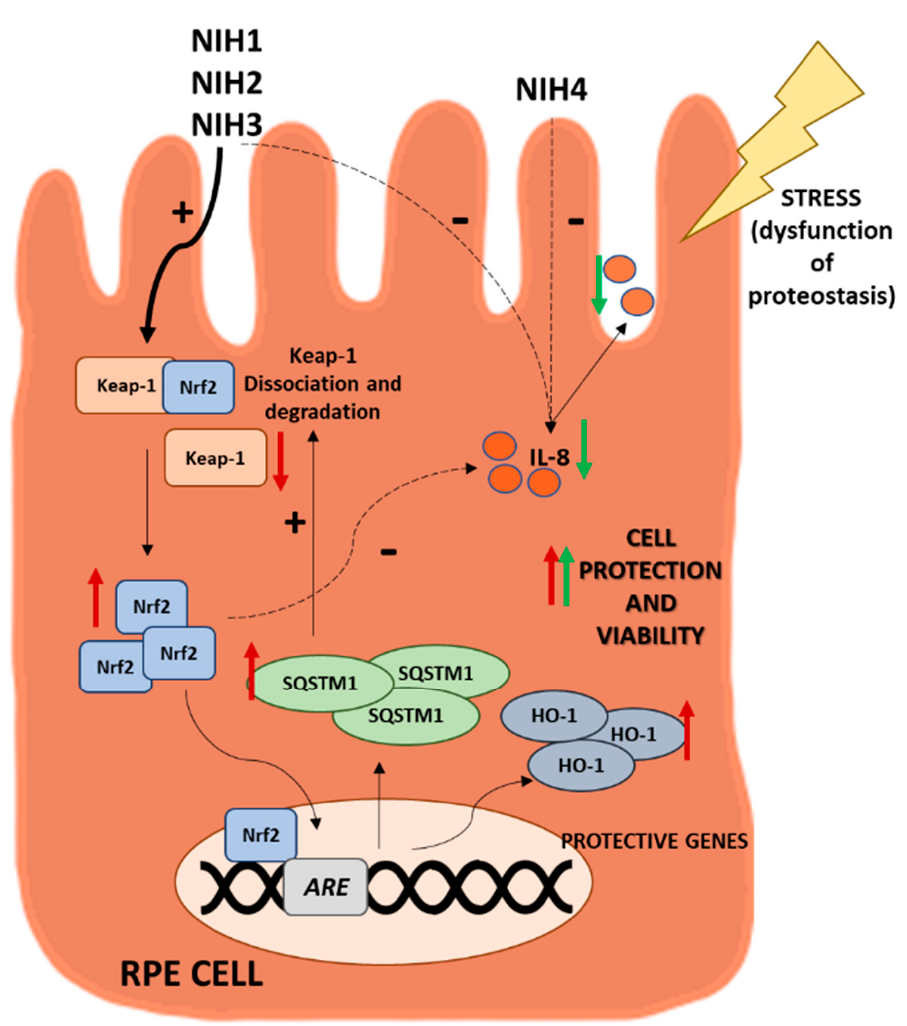
Figure 8. Summary of the main protective effects induced by treatment with NIH compounds in ARPE-19 cells in normal conditions and under inhibitors of protein degradation systems. NIH1–3 are able to activate Nrf2 by binding to Keap1 proteins, inducing a decrease in them. Nrf2 induces upregulation of both HO-1 [37] and SQSTM1/p62. Moreover, these compounds decrease IL-8 release and improve cell viability under stress. NIH4 shows a mild effect on cell survival and IL-8 release via an Nrf2-independent pathway. See the text for details.